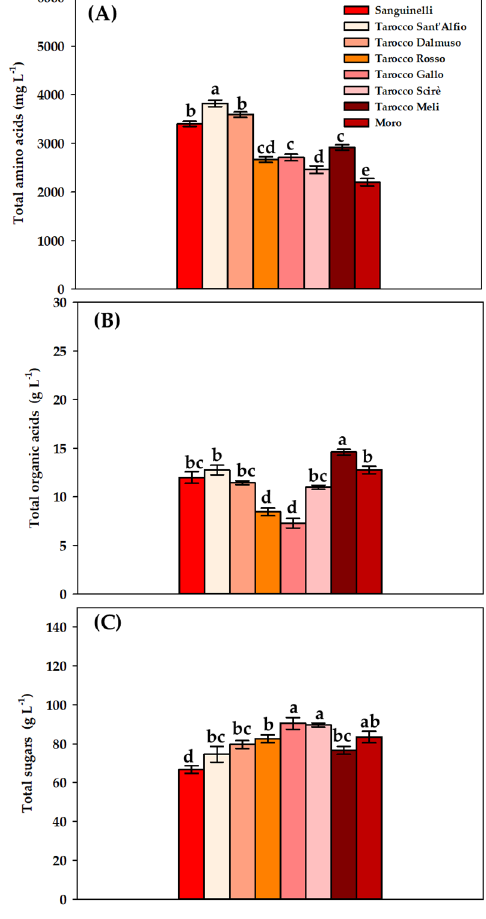
Figure 2. Total content of amino acids ( A ), organic acids ( B ) and sugars ( C ) in juice of eight blood orange varieties (Sanguinelli, Tarocco Sant’Alfio, Tarocco Dalmuso, Tarocco Rosso, Tarocco Gallo, Tarocco Scirè, Tarocco Meli and Moro) grafted on Citrus macrophylla. Data are the mean ± SE ( n = 6). Di ff erent le tt ers indicate statistically signi fi cant di ff erences (ANOVA, HSD Tukey test; p < 0.05).